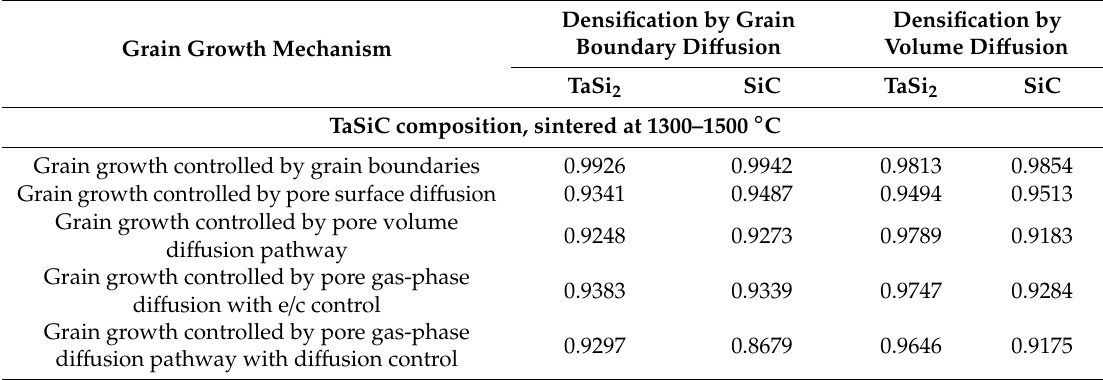
Table 3. Regression coe ffi cient values (R 2 ) for the di ff erent (densification mechanism and grain growth mechanism)